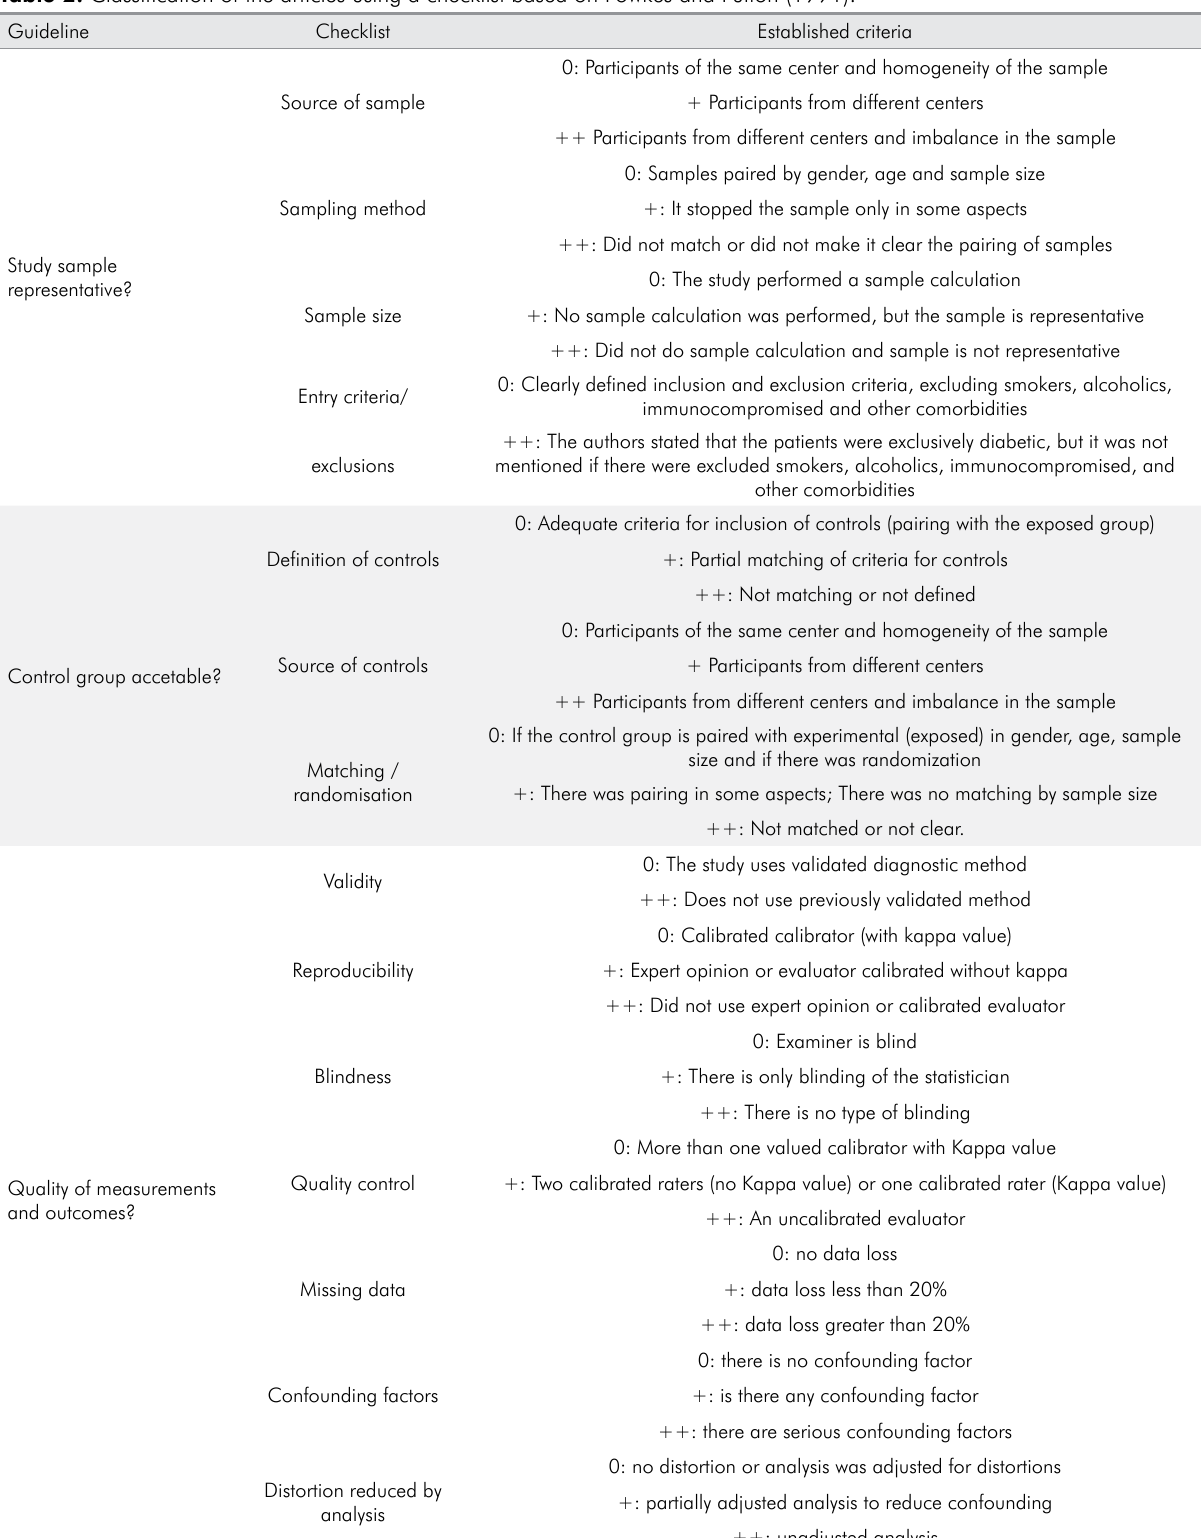
Table 2. Classification of the articles using a checklist based on Fowkes and Fulton (1991).